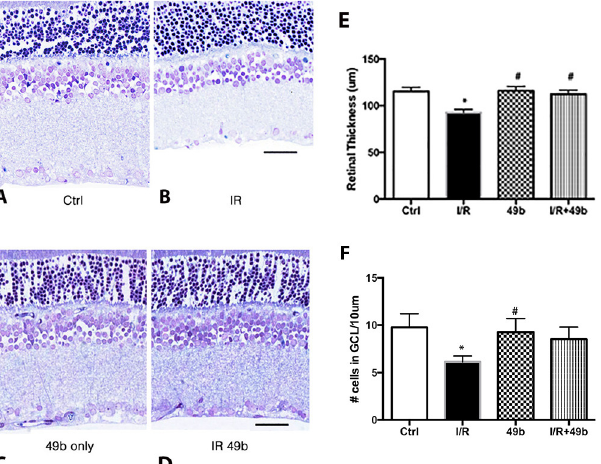
Fig 1. Compound 49b can overcome ischemia/reperfusion-induced decreases in retinal thickness. Panel A represents the control (left eye). Panel C represents eyes treated with 1mM Compound 49b only. Panels B, D are eyes exposed to ischemia/reperfusion (B) or I/R+Compound 49b (D). Panel E provides a graphical demonstration of the mean ± SEM for retinal thickness in each group. Panel F provides a graph for the numbers of cells in the ganglion cell layer. Data is mean ± SEM. N = 5 for each group. * P < 0.05 vs. control; # P < 0.05 vs. I/R only without Compound 49b.